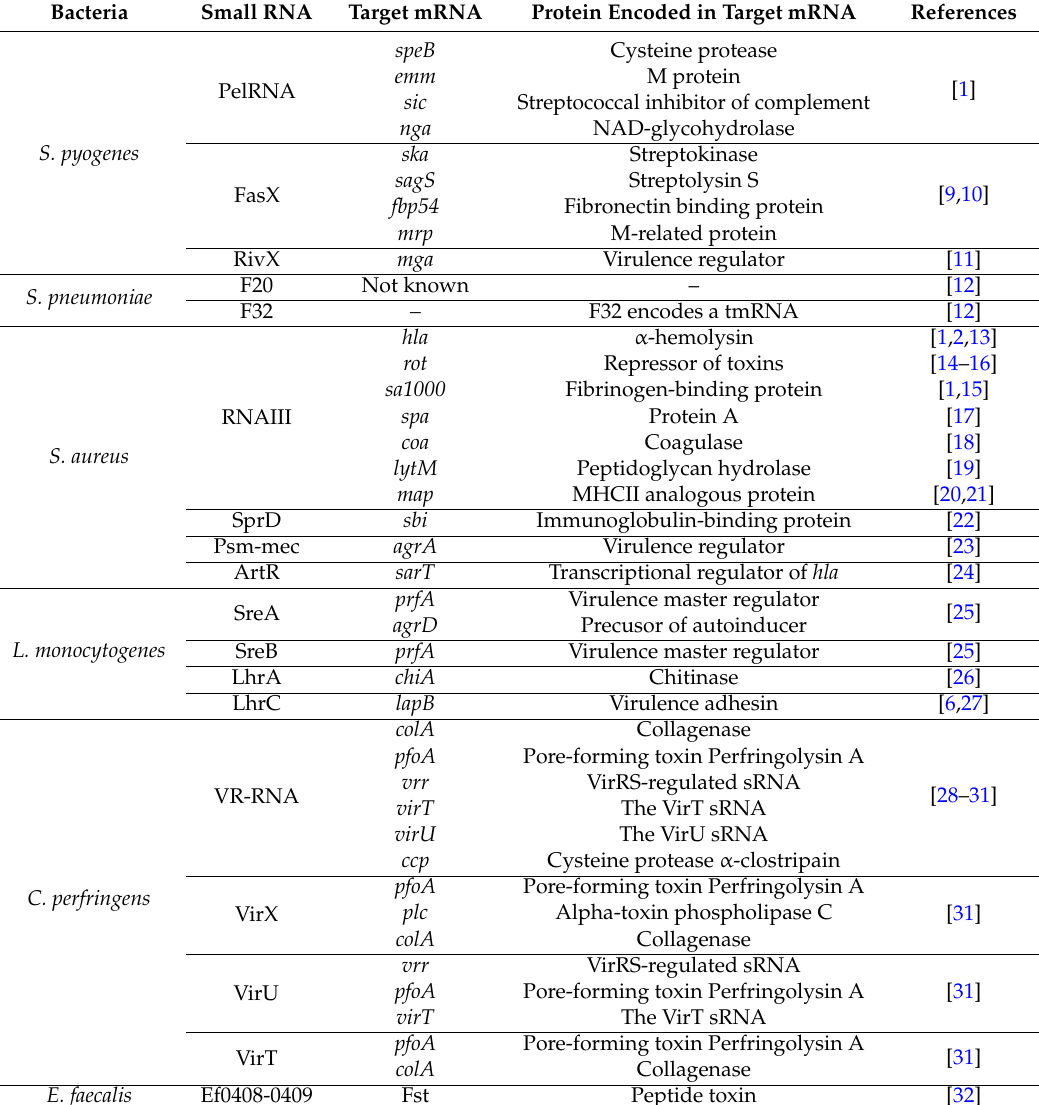
Table 1. Small regulatory RNAs influencing virulence of gram-positive